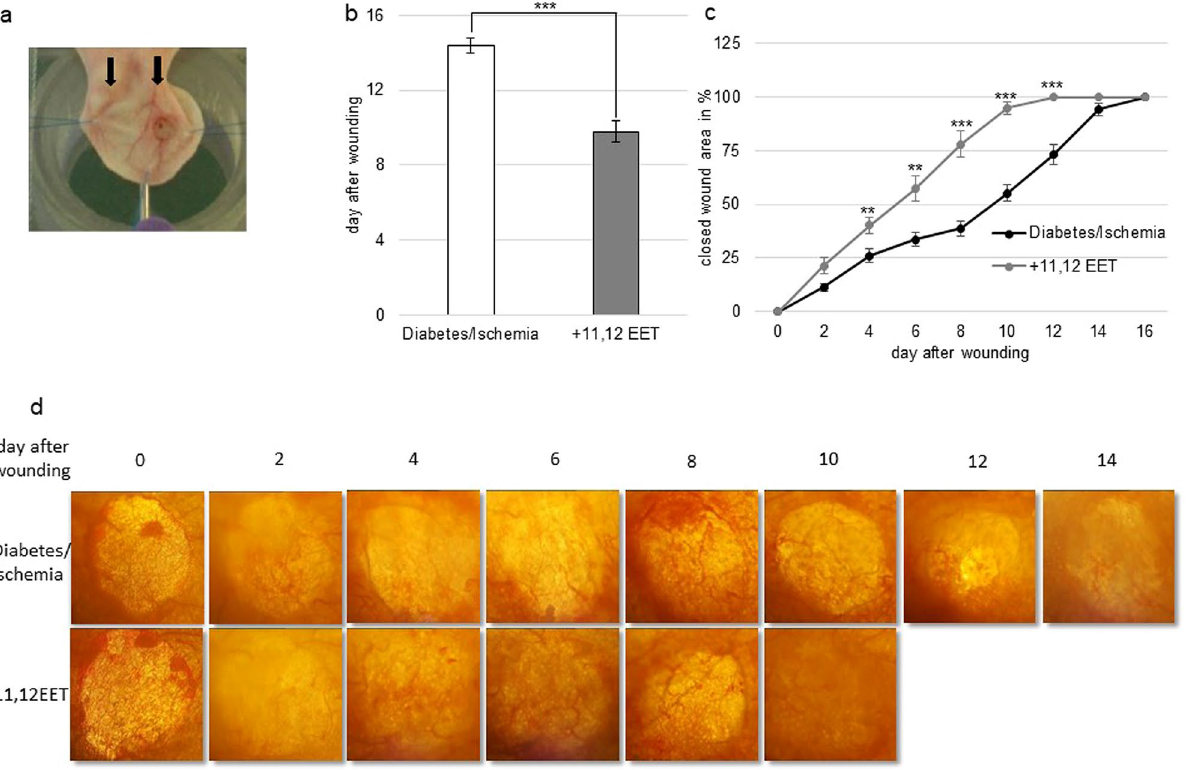
Figure 1. ( a ) Photograph of the wound on the mouse ear. Black arrows indicating the two ligated vessels. ( b ) Day of wound closure. Comparison between non-treated and 11,12 EET treated ischemic wounds in diabetic mice. ( c ) Percentage of closed wound area from day 0–16. Comparison between ischemic wounds of diabetic animals with or without 11,12 EET treatment. ( d ) Representative pictures of ischemic wounds throughout the wound healing process in diabetic mice and after treatment with 11,12 EET (data is shown as mean ± SD; n = 10 ). ** p < 0.01, *** p < 0.001.